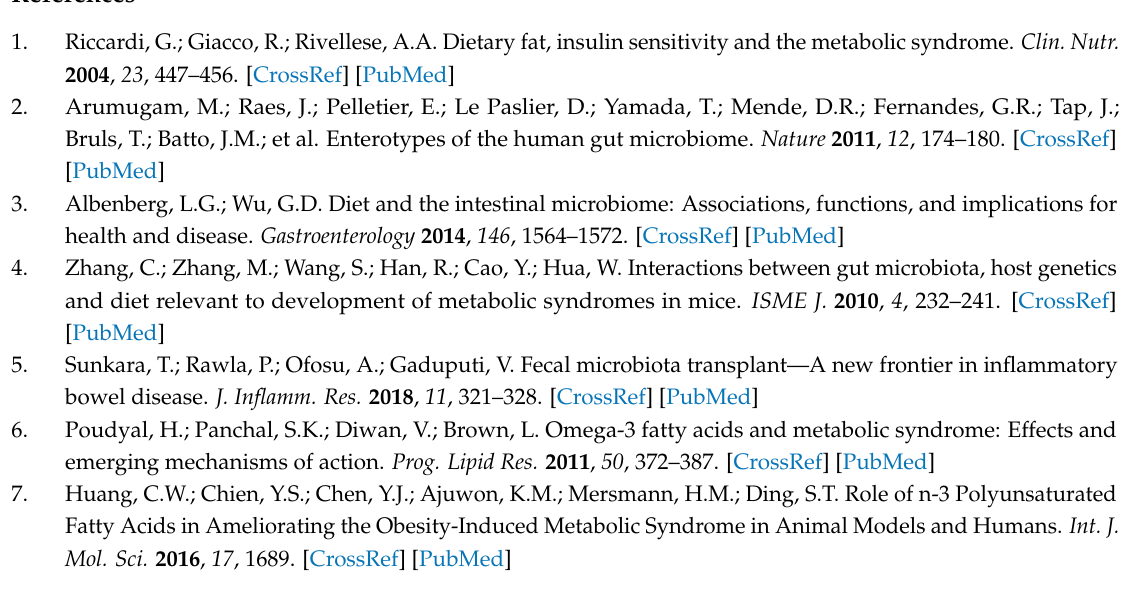
Table S1: p -values of Kruskal–Wallis test, and pairwise comparisons of nonadjusted and adjusted p -values of the families with significant differences between diets in the percentage of sequences retrieved from fecal